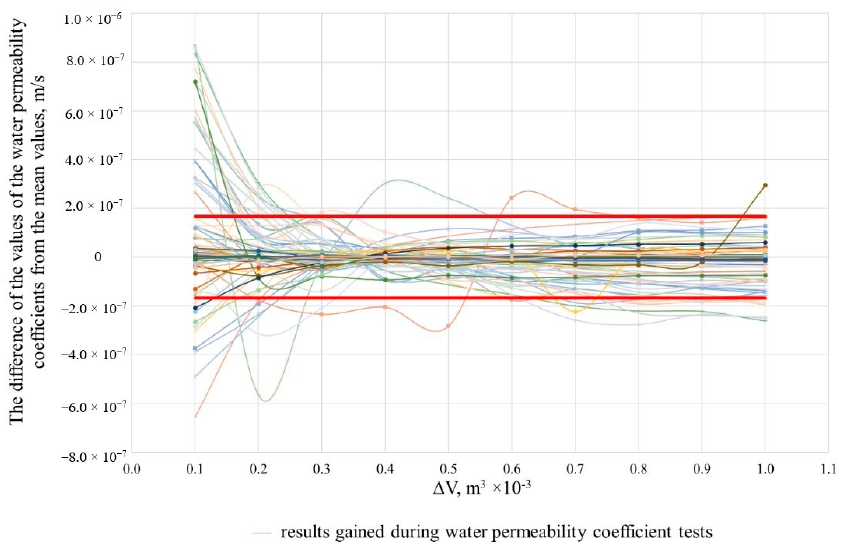
Figure 7. The distribution of the values of the water permeability coefficients from the mean values, taking into account the stage when the data for the calculation of this coefficient were recorded.